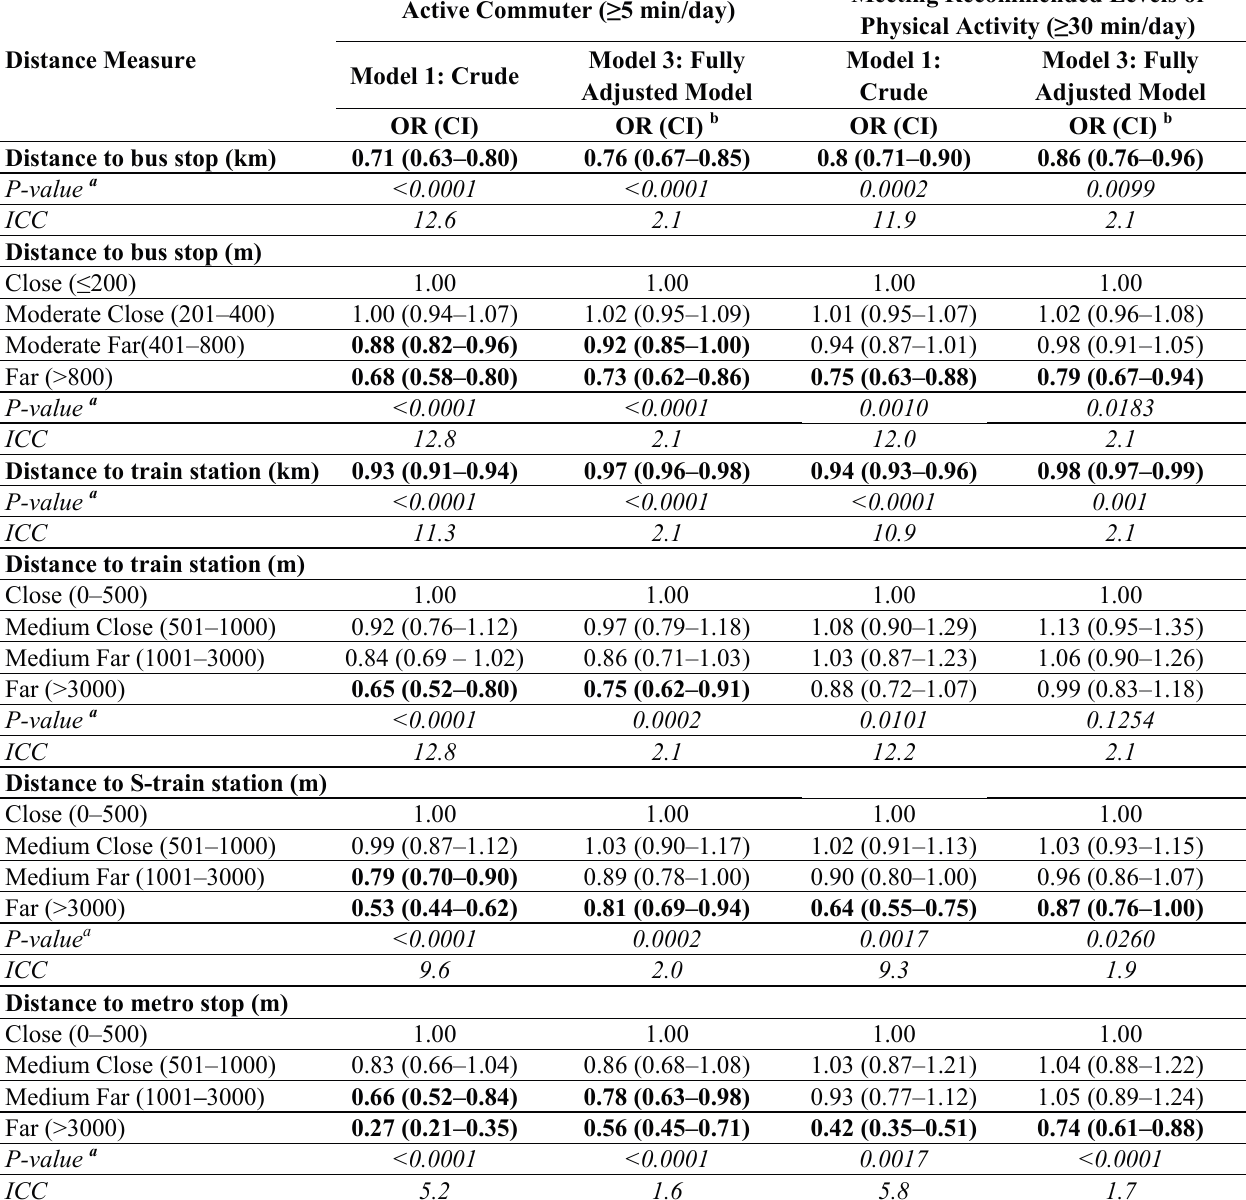
a P -value from type III test of the association. b All models adjusted for neighbourhood confounders population density, median income, street connectivity and individual confounders. Bus distance adjusted